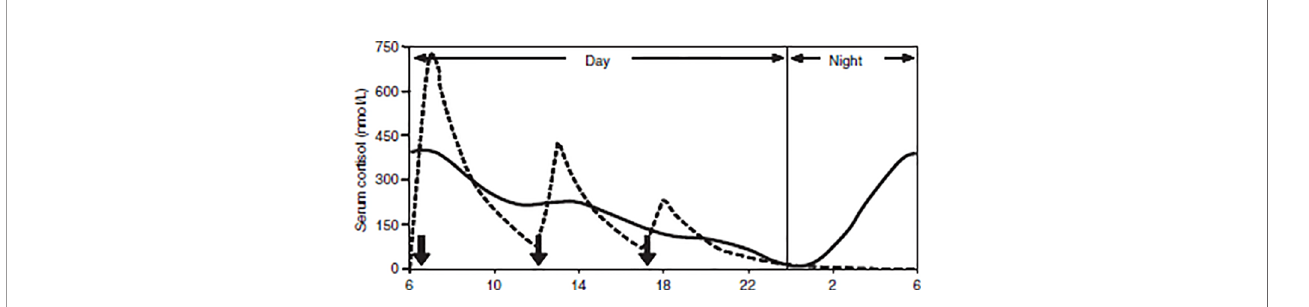
FIGURE 3 | Simulated cortisol pro fi le for a patient [broken line] following thrice-daily hydrocortisone administration [10mg at 06:00, 5mg at 12:00 and 2.5mg at 18:00, shown as solid arrows]. The normal circadian rhythm of cortisol [solid line]. From Mah et al. (211). Weight ‐ related dosing, timing and monitoring hydrocortisone replacement therapy in patients with adrenal insuf fi ciency. Clinical Endocrinology, 61(3)